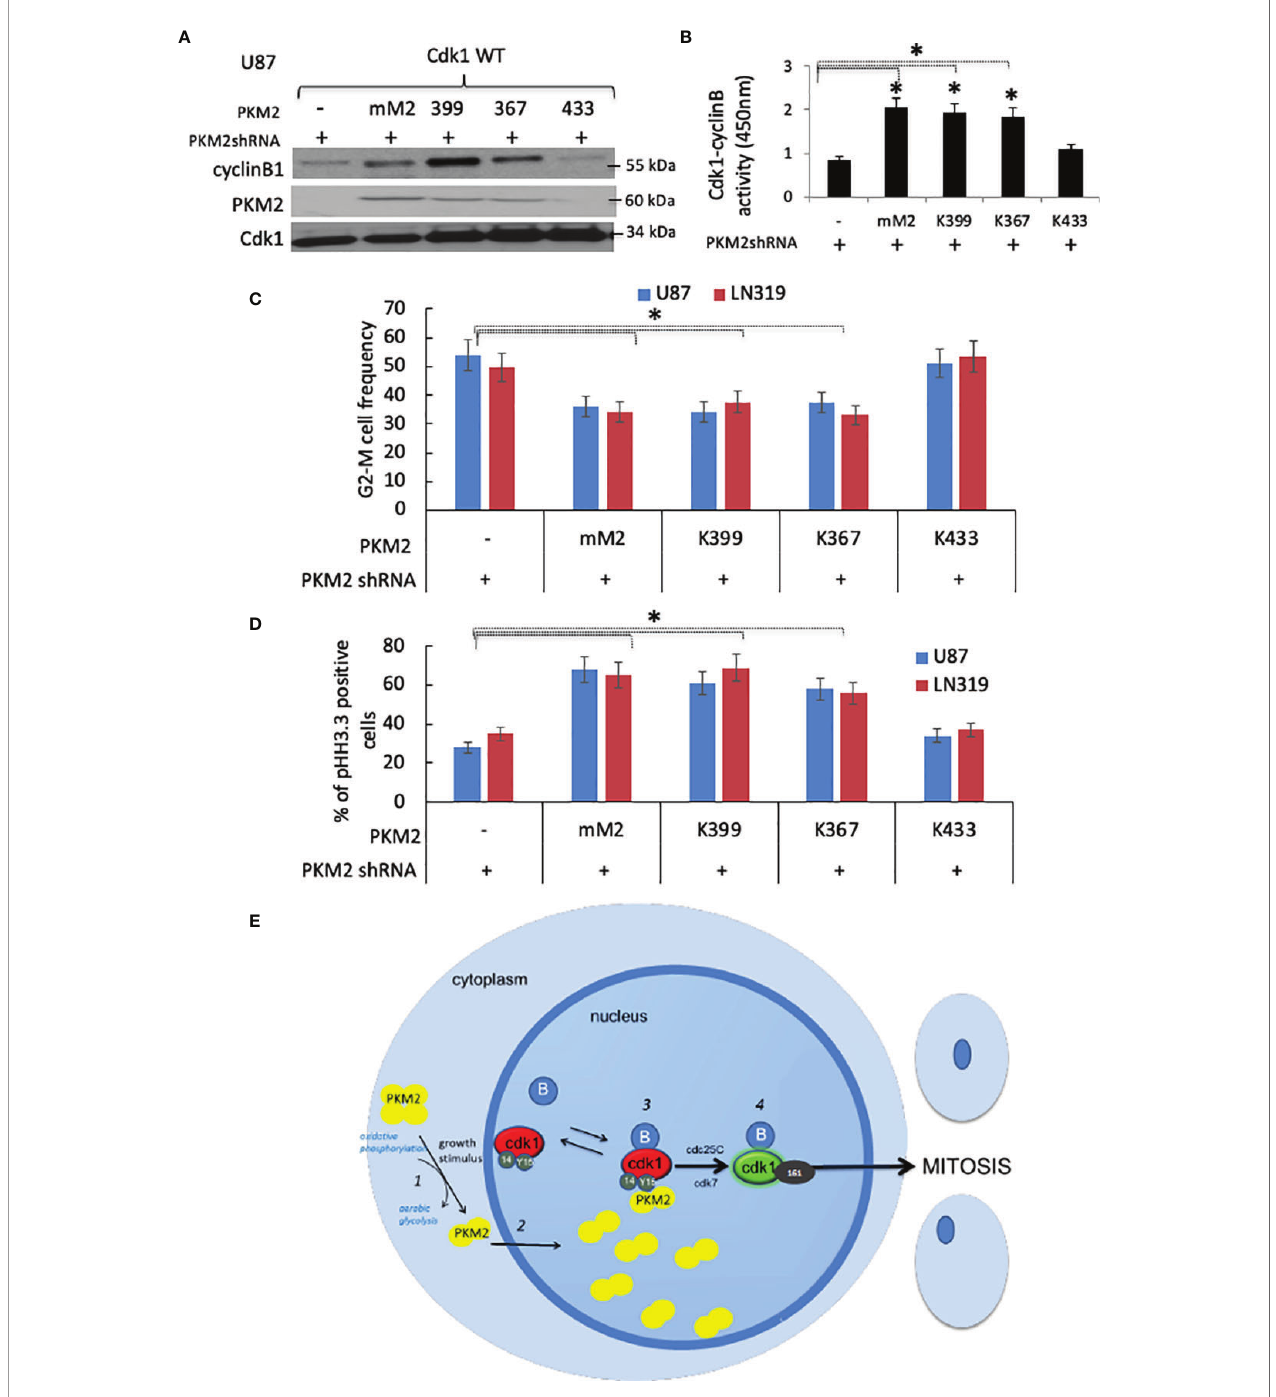
FIGURE 5 | PKM2 uses its pY-binding ability to facilitate Cdk1-cyclin B activation and cell cycle progression (A) Levels of cyclin B1, PKM2, Cdk1, and (B) Cdk1- cyclin B activity in nuclear GFP immunoprecipitates from PKM2 shRNA-expressing U87 cells expressing GFP-tagged WT Cdk1 and mouse WT (mM2) or R399E, K367M, or K433E forms of PKM2 measured 10 hrs after release of cells from serum deprivation-induced arrest. (C) FACS-based cell cycle distribution in U87 and LN319 cells containing constructs encoding a scrambled shRNA or PKM2 shRNA, mouse PKM2, or various mutant forms of PKM2. *p <.05, n=3. (D) cells from panel-C were assessed for the percentage of mitotic pHH3.3+ cells by FACS (E) Proposed model by which PKM2 interacts with the Cdk1-cyclin B complex to drive mitotic progression in tumor cells. Extracellular events that stimulate tumor cell growth trigger dimerization of PKM2 and a shift in metabolism (1). PKM2 dimers move into the nucleus (2) where they interact with Y15-phosphorylated Cdk1-cyclin B complexes (3). The interaction, perhaps through complex stabilization increases the likelihood of Cdk1 activation (4). Cdk1 activation allows the cellular metabolic state to match the cellular proliferative